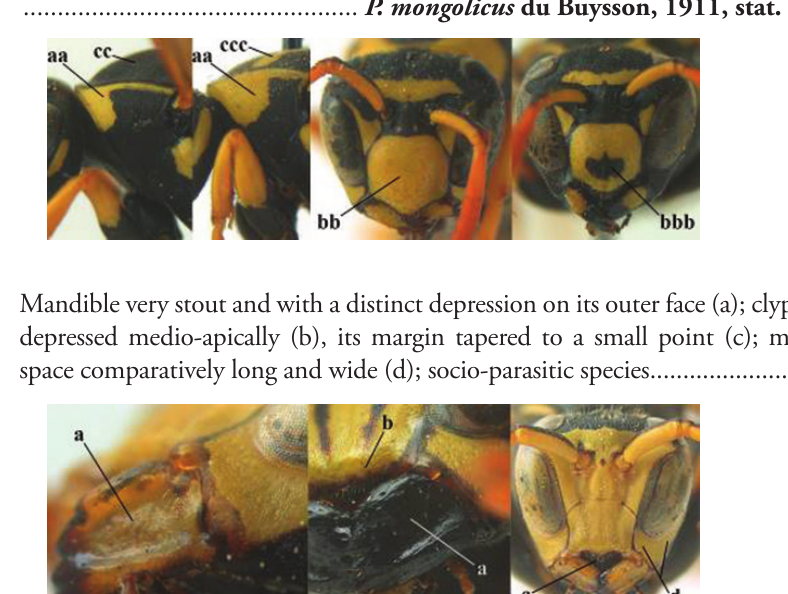
– Transverse yellow band of pronotum dorso-laterally wider than medio-lat- erally (aa); clypeus entirely yellow (bb) or with minute black spot, but spot sometimes medium-sized (bbb); mesoscutum usually black (cc) or with pair of small yellow spots (but sometimes large in Asian specimens; ccc); Croatia and SE Europe, Turkey, Cyprus to Central Asia and Egypt ...........................